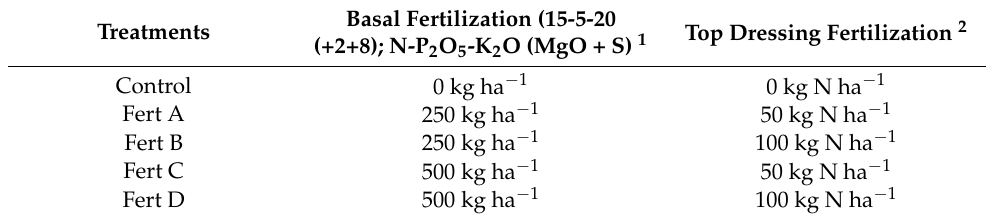
Table 2. Fertilization treatments conducted in experiment